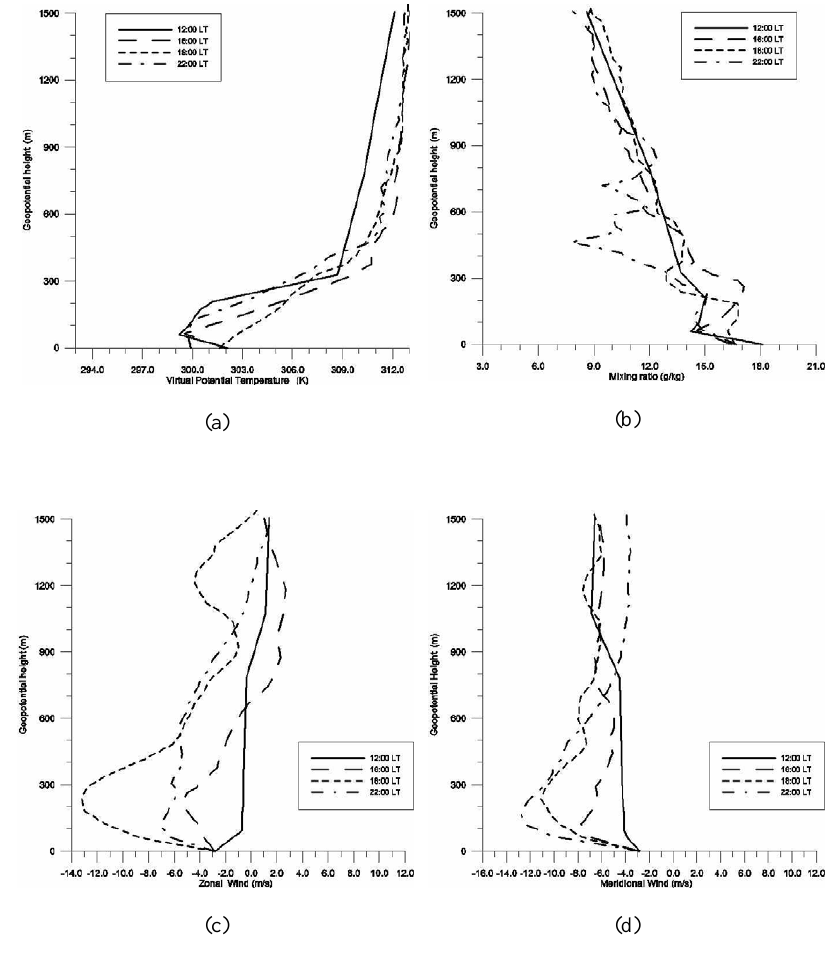
Fig. 3. Vertical profiles of: (a) virtual potential temperature ( θ v ) , (b) mixing ratio (r w ) , (c) zonal wind (u) , and (d) meridional wind (v) component, respectively, on 9 January